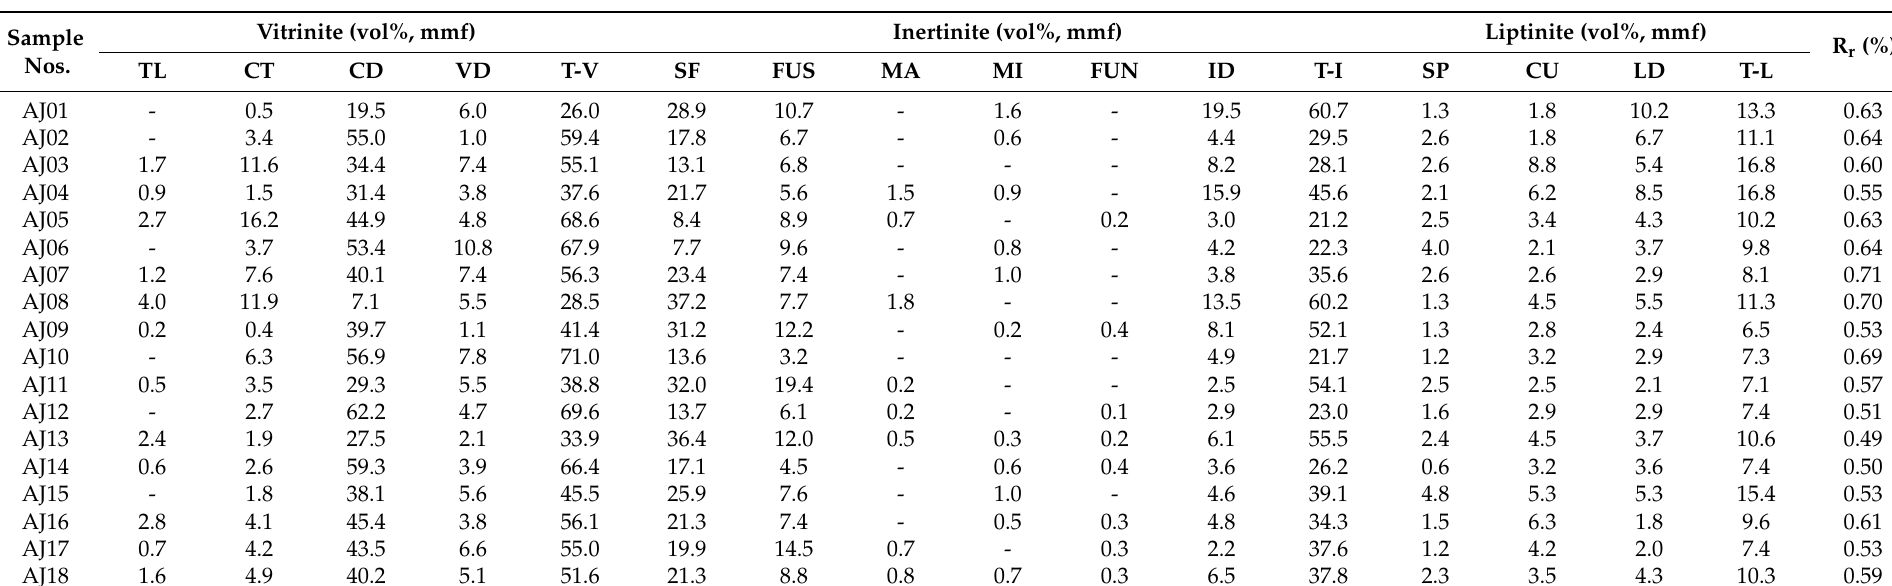
Table 1. Maceral composition of No. 9 coal